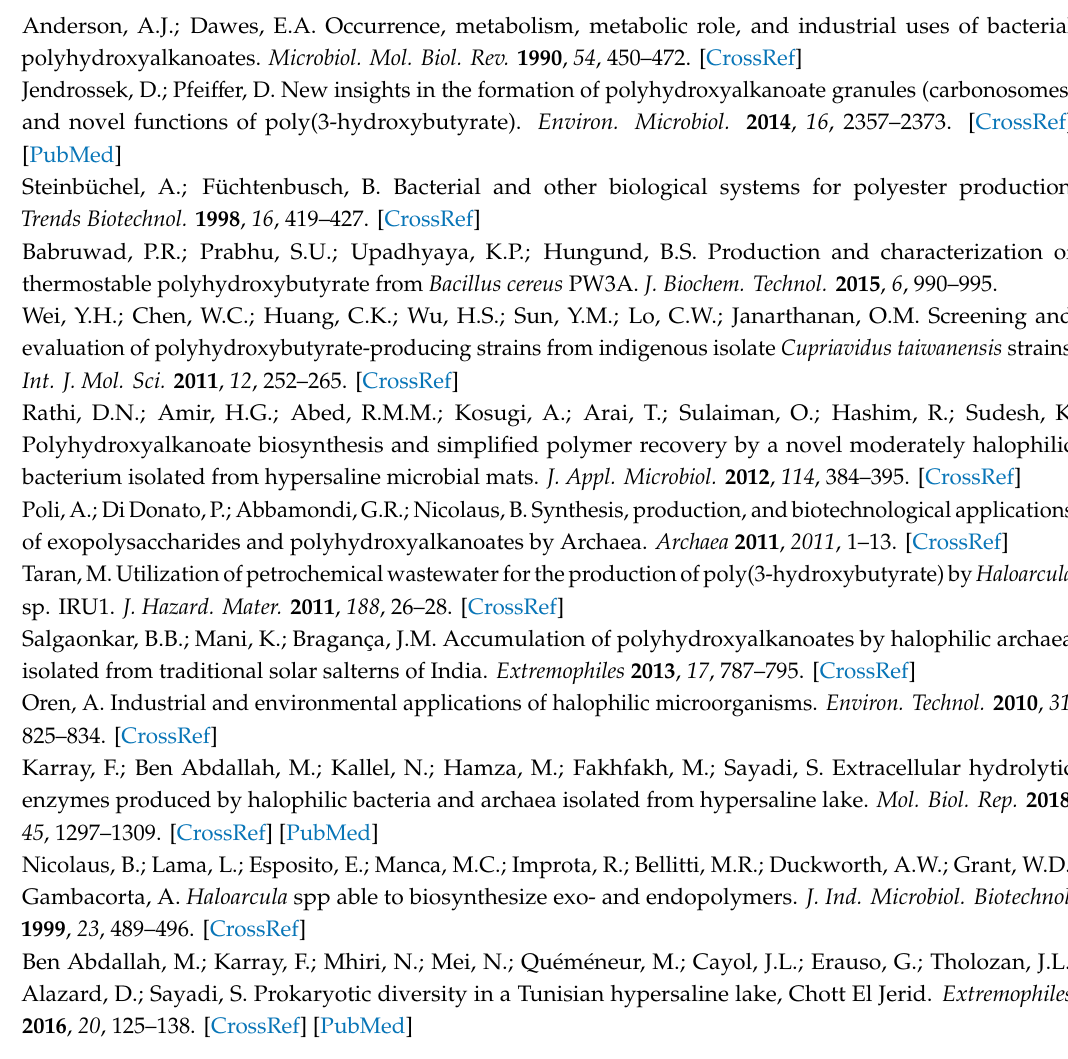
Figure S1: Spectrophotometric scans of crotonic acid of PHA obtained from strains CEJGTEA101 (yellow line) and CEJEA36 (red line) grown in PHA production media supplemented with 2% ( w / v ) of glucose (best substrate) under optimized conditions of cultivation compared with standard PHB purchased from Sigma-Aldrich (brown